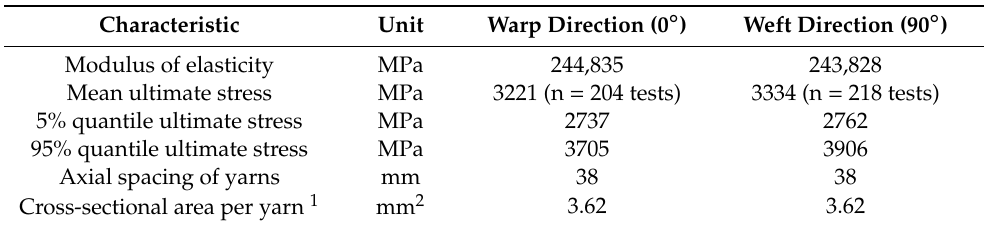
Table 1. Material characteristics of the carbon textile solidian GRID Q95/95-CCE-38 (properties of one individual yarn [41], test setup according to [42]).